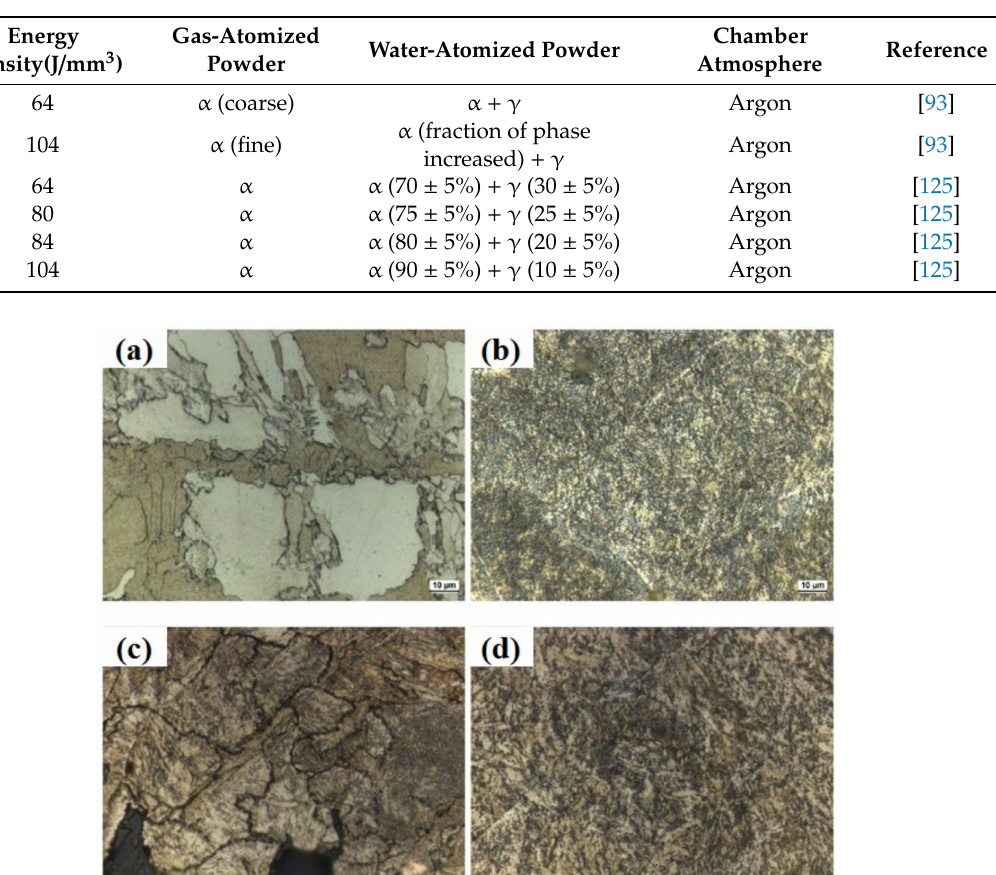
Table 2. The e ff ect of energy destiny on the amount of retained austenite of parts obtained by gas-atomized and water-atomized powder (material: 17–4 steel).